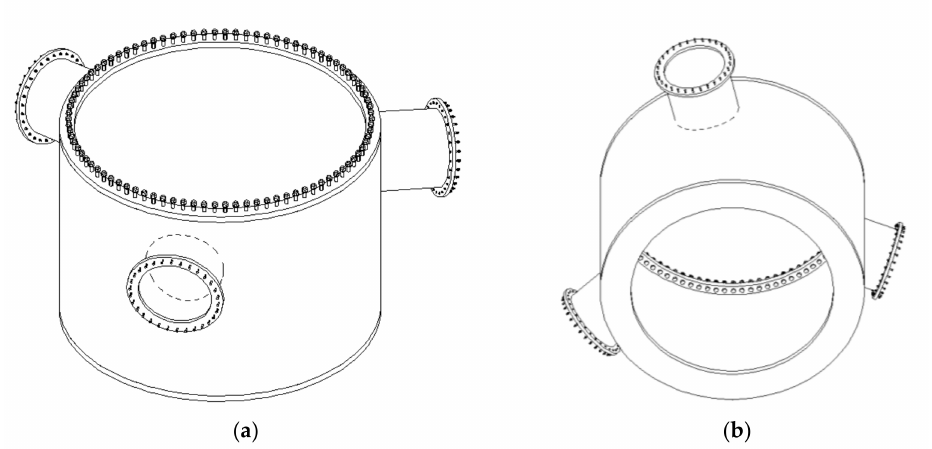
Figure 5. Details of a unified lower junction piece: ( a ) view from the top and ( b ) view from the